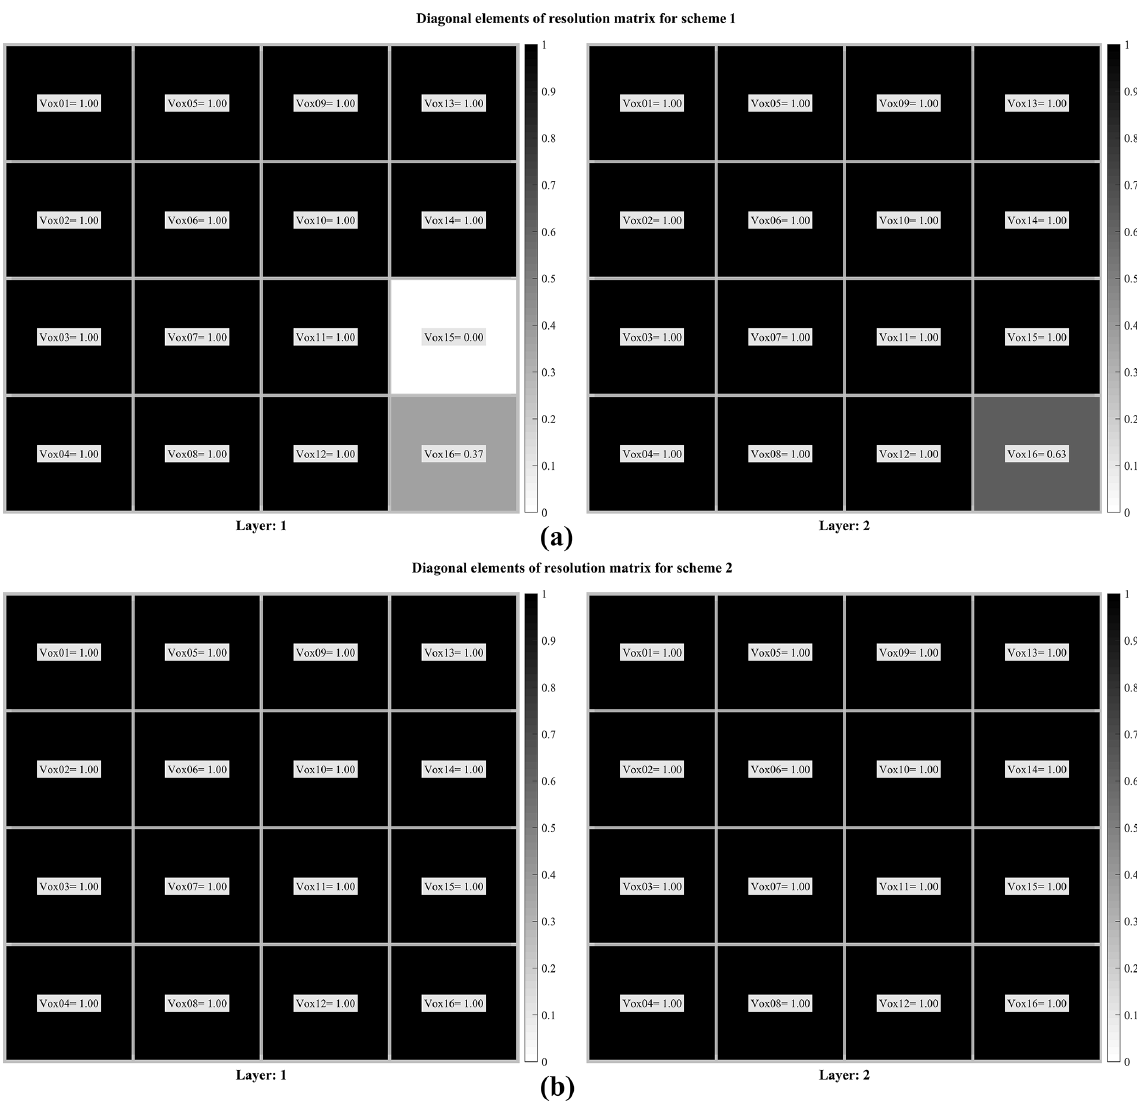
Figure 6. Diagonal elements of the resolution matrix in different layers for scheme 1 (a) and scheme 2 (b) .